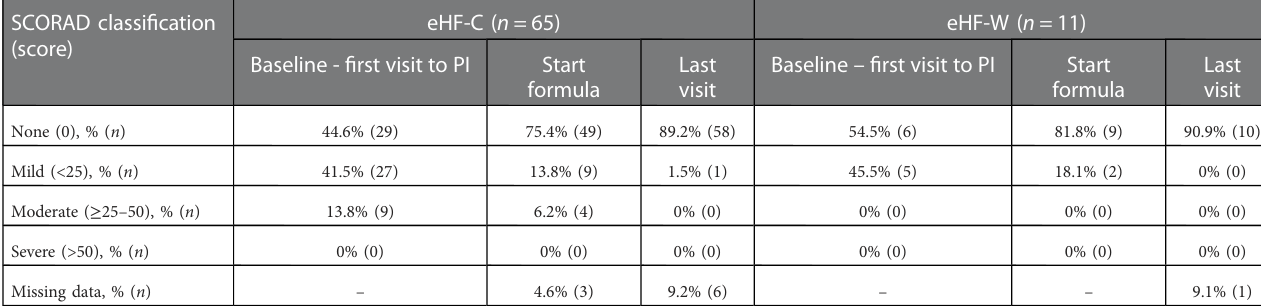
TABLE 5 SCORAD classi fi cations in both groups, presented as percentages (number of subjects). SCORAD classi fi